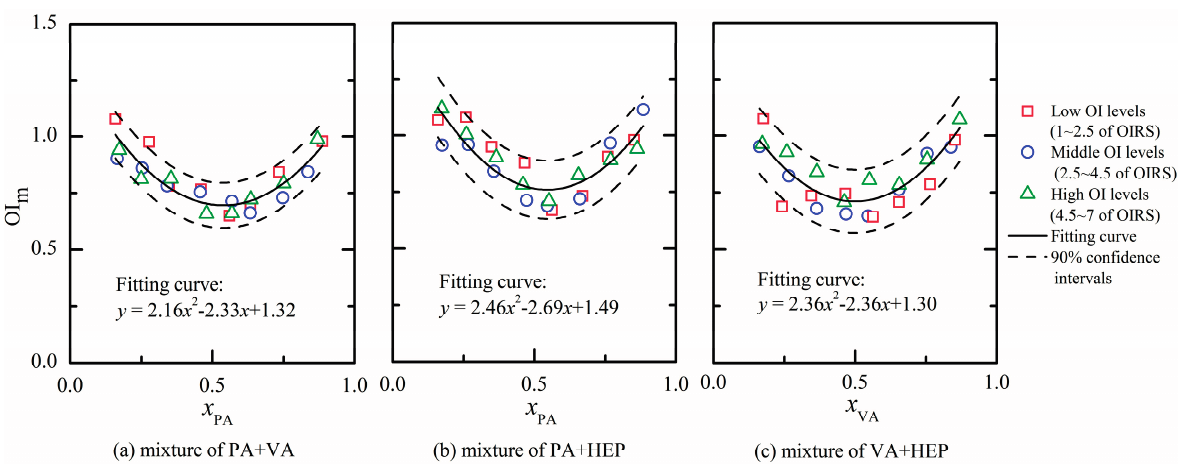
Figure 4. PDE models for binary mixture of: ( a ) propionaldehyde and n -valeraldehyde (PA + VA); ( b ) propionaldehyde and n -hexaldehyde (PA + HEP); ( c ) n -valeraldehyde and n -hexaldehyde (VA + HEP). The fitting curve of quadratic polynomial regression analysis (solid line) and corresponding confidence intervals (dashed line, confidence coefficient was 0.90) are